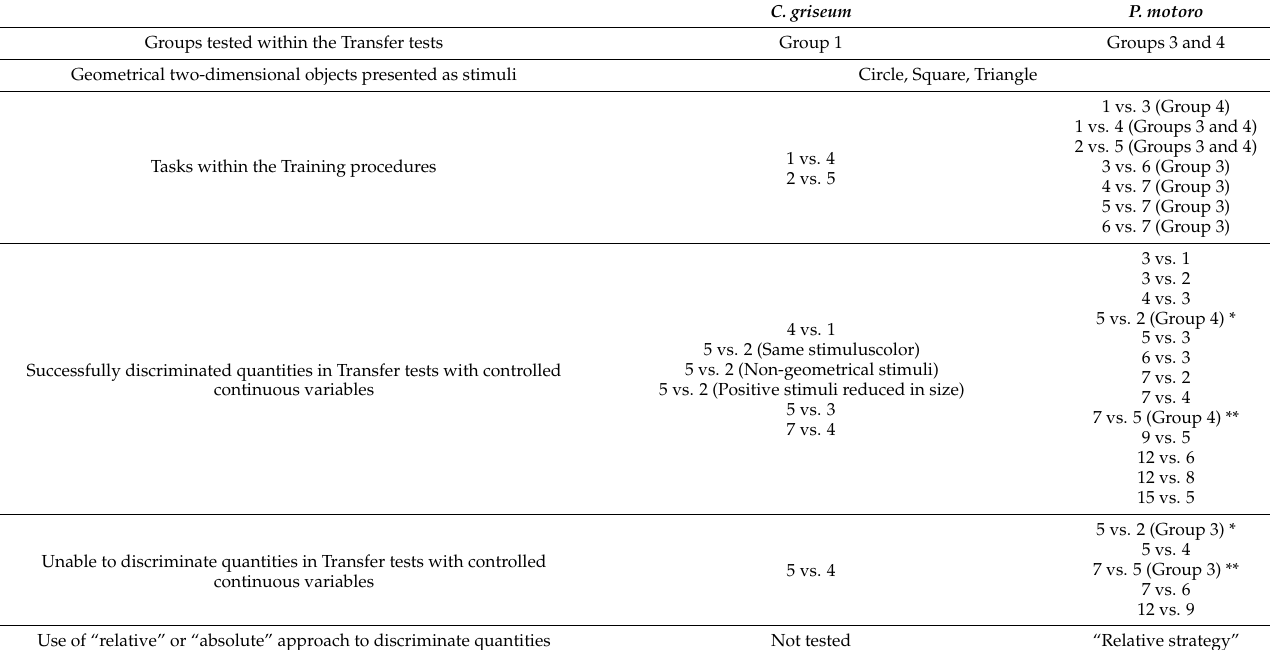
Figure 8. Exemplary graph of the performance of a ray during during the entire training and testing phase. The black line shows the percentage of correct choices per ten-trial session. The horizontal red dotted line indicates the lower limit of the LC, while the vertical red line indicates when the LC was achieved. In the sessions following the red vertical line, transfer tests were added to the regular ten trial session. The blue line gives the average trial time for each session. Table 1. Overview of both species performance in the transfer tests. * Two individuals of Group 4 were able to discriminate 5 vs. 2 while three individuals of Group 3 were not. ** Three individuals of Group 4 were able to discriminate 7 vs. 5 while one individual of Group 3 was